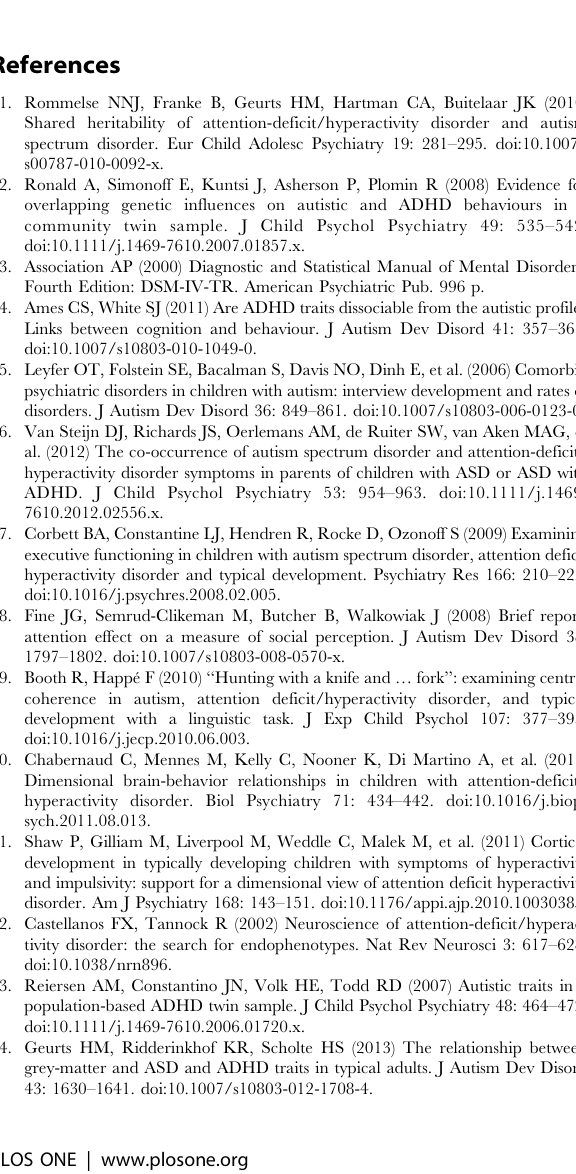
Table S1 Medication Information. Table S2 Distribution of Scanning over Two Sites. Table S3 Correlation between ASD score and ADHD symptom levels.